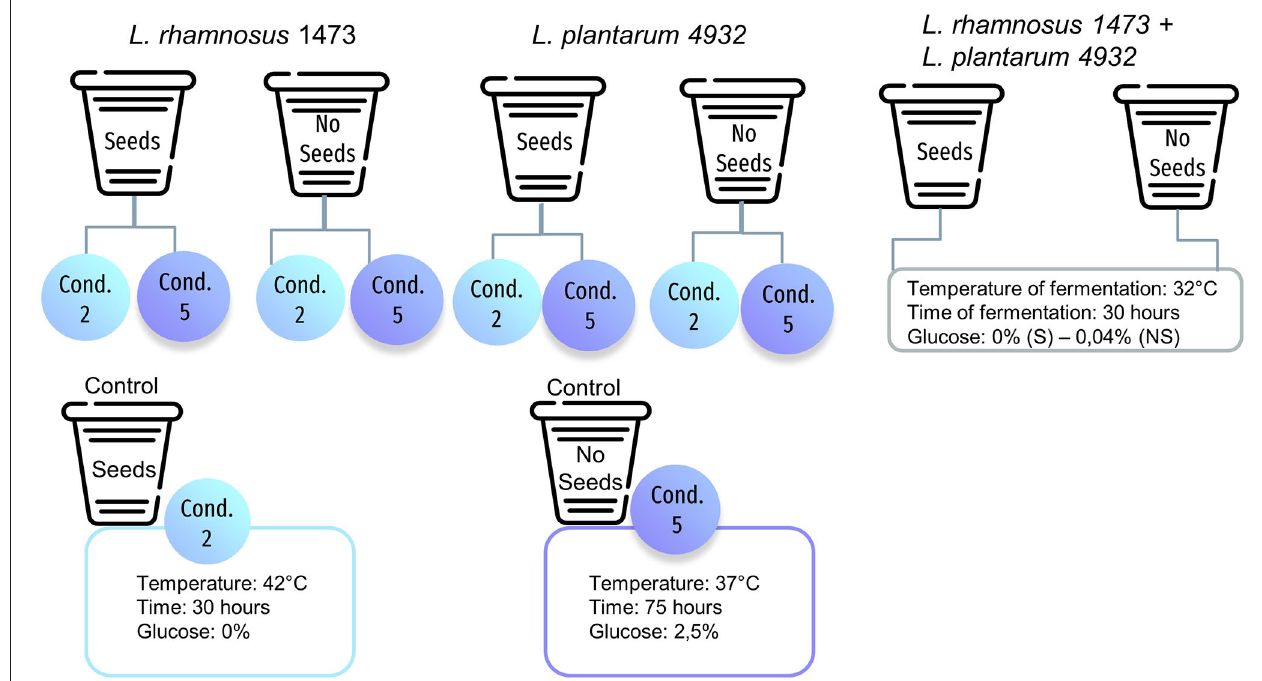
FIGURE 2 | Example of experimental conditions used for sensory analysis for strains with the optimal growth temperature of 37 ◦ C. S is the sample with seeds; NS is the sample without seeds.